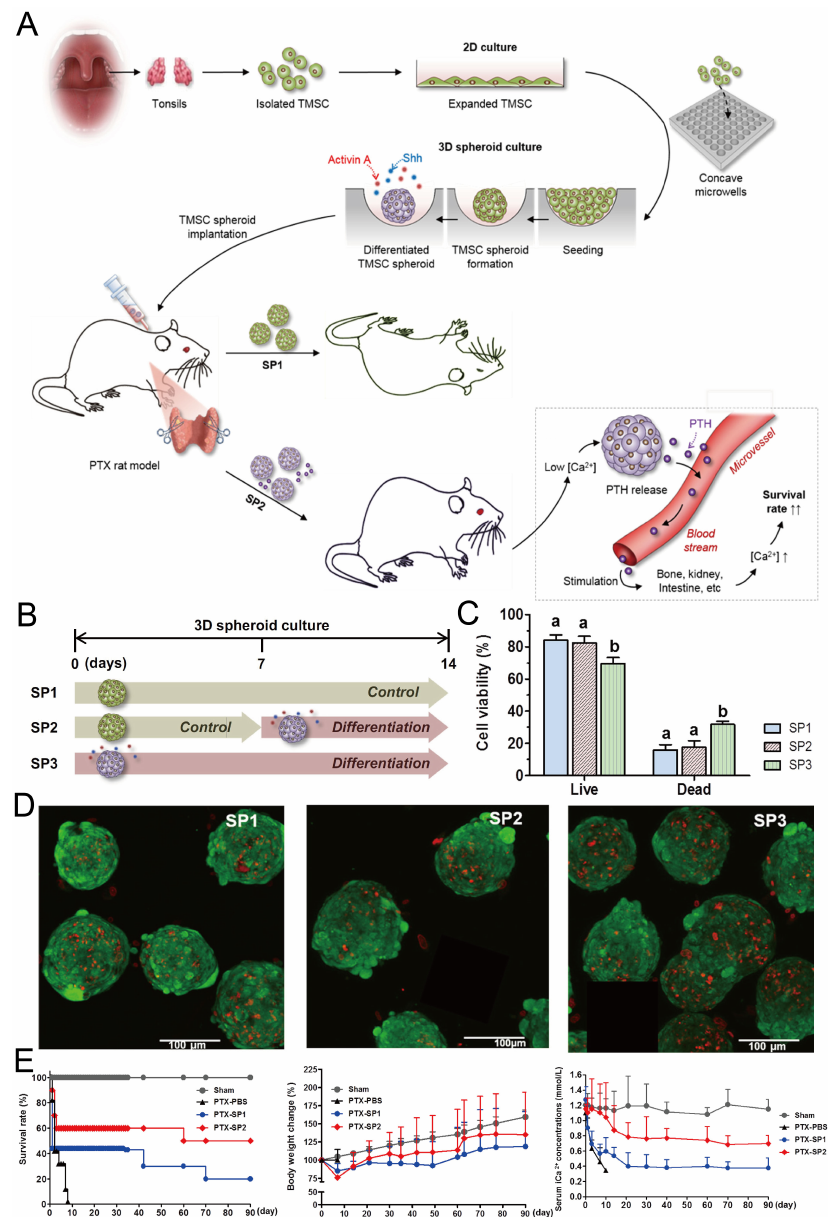
Figure 21. Formation of tonsil-derived mesenchymal stem cells (dTMSC) spheroids and their appli- cation in parathyroid tissue engineering [100]. ( A ) The schematic view of experimental procedures: at first, TMSCs were isolated from tonsils and then cultured in concave microwells; secondly, three different types of TMSC spheroids were formed under different culture conditions; thirdly, two types of TMSC spheroids were implanted into PTX rats to check their potential in hypoparathyroidism. ( B ) Three different types of TMSC spheroids: SP1 refers to the spheroids formed by culturing TMSCs in control medium for 14 days, SP2 refers to the spheroids formed by culturing TMSCs in control medium for the first 7 days and differentiation medium for the second 7 days, and SP3 refers to the spheroids formed by culturing TMSCs in differentiation medium for 14 days. ( C ) The viability of TMSCs in SP1, SP2, and SP3, respectively. ( D ) Fluorescent pictures of SP1 (left), SP2 (middle), and SP3 (right) stained by a live/dead assay, in which the green indicates the live cells and the red indicates the dead cells. ( E ) The comparison of survival rate (left), body weight change (middle) and serum iCa 2 + concentration (right) of PTX rats implanted with SP1 and SP2 in 90 days. PBS served as a negative control. Sham refers to rats with sham operation but no spheroid